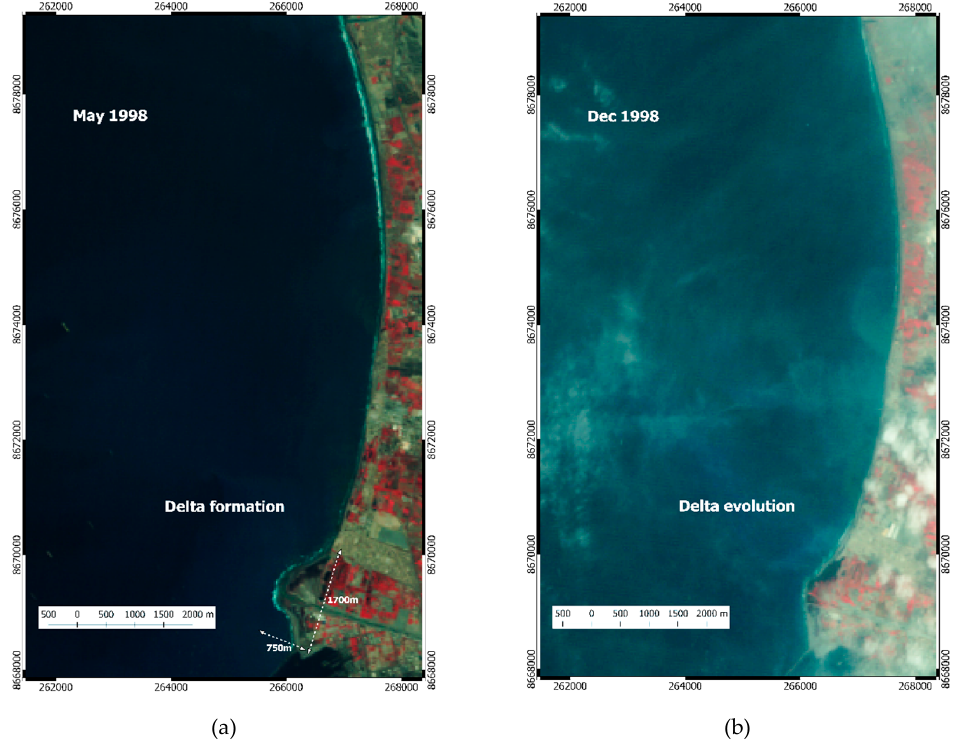
Figure 6. Rimac Delta formation in 1998, a ) Just after the EN occurs, b ) 8 months later.